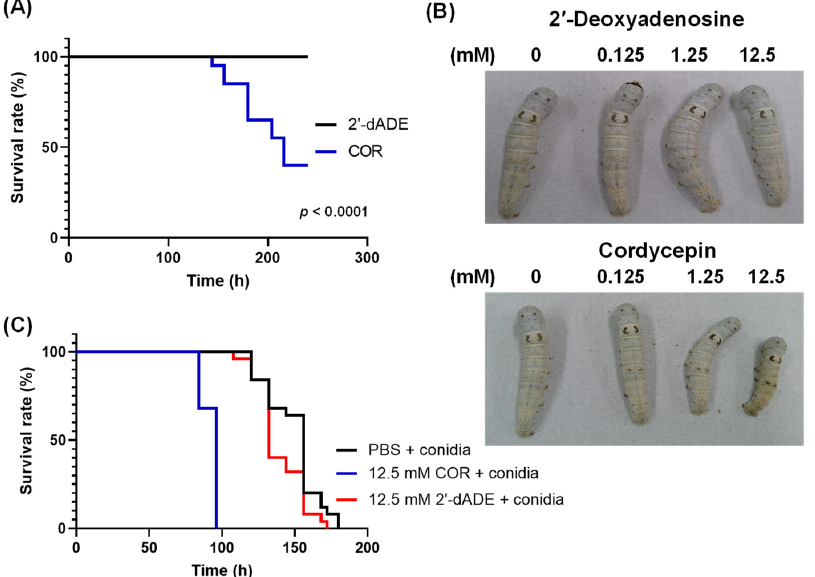
Figure 4. Effect of cordycepin in vivo. ( A ) Survival of silkworm larvae injected with 100 μ L of 12.5 mM cordycepin or 2 ′ -deoxyadnosine ( n = 5, triplicate). COR and 2 ′ -dADE indicate cordycepin and 2 ′ -deoxyadenosine. Results are significantly different using the log-rank test ( p < 0.0001, χ 2 = 16.99). ( B ) Appearance of larvae at three days after injection with of cordycepin or 2 ′ -deoxyadnosine. ( C ) Survival of larvae injected with 50 μ L of 12.5 mM cordycepin or 2 ′ -deoxyadnosine and 25 μ L of 1 × 10 6 conidia/mL of C. militaris NBRC103752 conidia ( n = 5 or 10, triplicate). COR and 2 ′ -dADE indicate cordycepin and 2 ′ -deoxyadenosine. Survival rates for cordycepin and 2 ′ -deoxyadnosine were significantly different using the log-rank test ( p < 0.0001, χ 2 = 83.08). Next, we injected conidia from B. bassiana NBRC4848 and M. anisopliae NBRC8556 along with cordycepin. B. bassiana and M. anisopliae are well-known as entomopathogenic fungi, but do not produce cordycepin. Cordycepin significantly increased the virulence of these fungi to larvae (Figure 5). The enhancement of its virulence with cordycepin corre- sponded to that of C. militaris (Figure 4C).